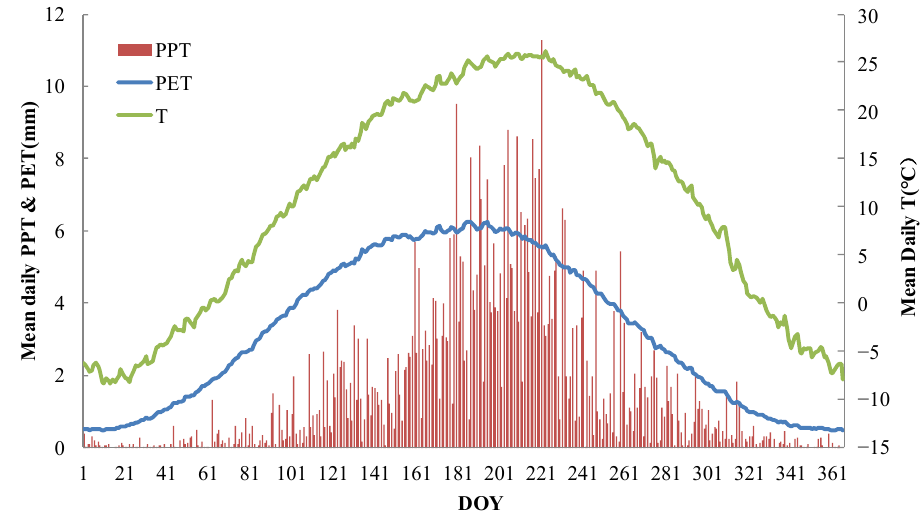
Figure 3. Mean daily precipitation (PPT), temperature (T), and potential evapotranspiration (PET) in rainfed maize farmland from 1989 to 2018. DOY is the day of the year, counting the number of days from January 1 of the current year, the same as follows.